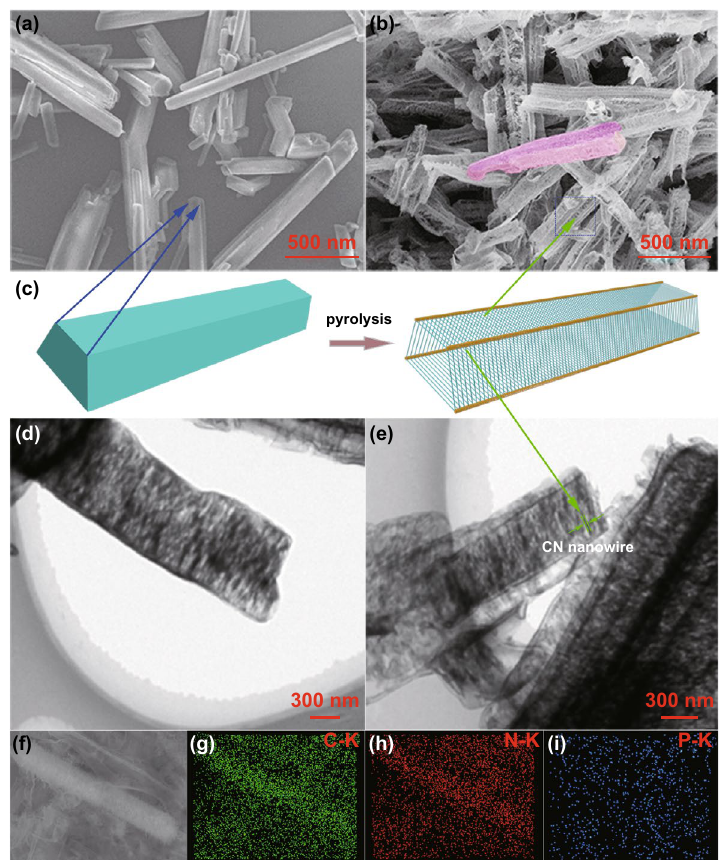
Fig. 2 Structural characterization of L‑PCN. a Typical SEM images of L‑PCN‑1.0 supramolecular precursor. b SEM images of L‑PCN‑1.0 after thermal treatment with 500 °C, 4 h. c Quadrangular and louver model of the supramolecular precursor and L‑PCN nanowire arrays. d ,